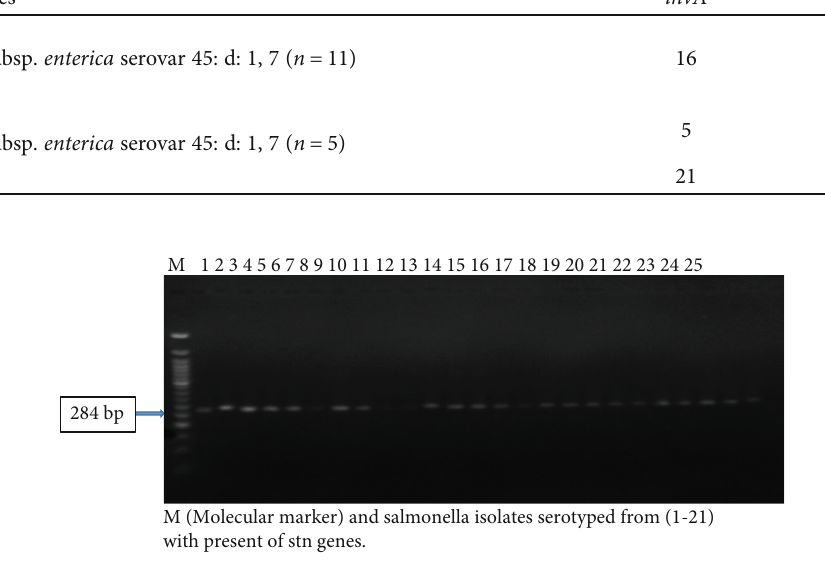
Table 7: The presence of virulence genes from Salmonella serovars from the Ilorin metropolis. Location of the samples